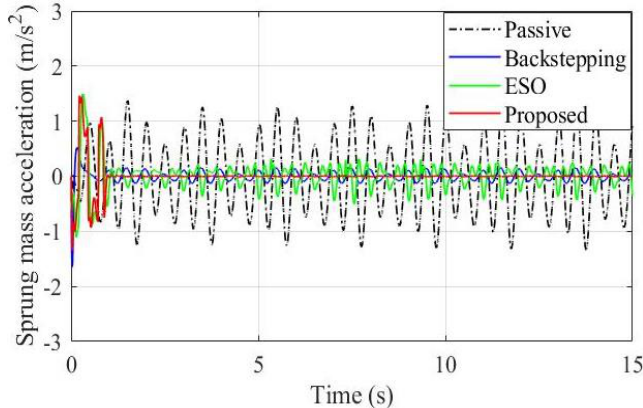
Figure 5. Simulation result of sprung mass acceleration.